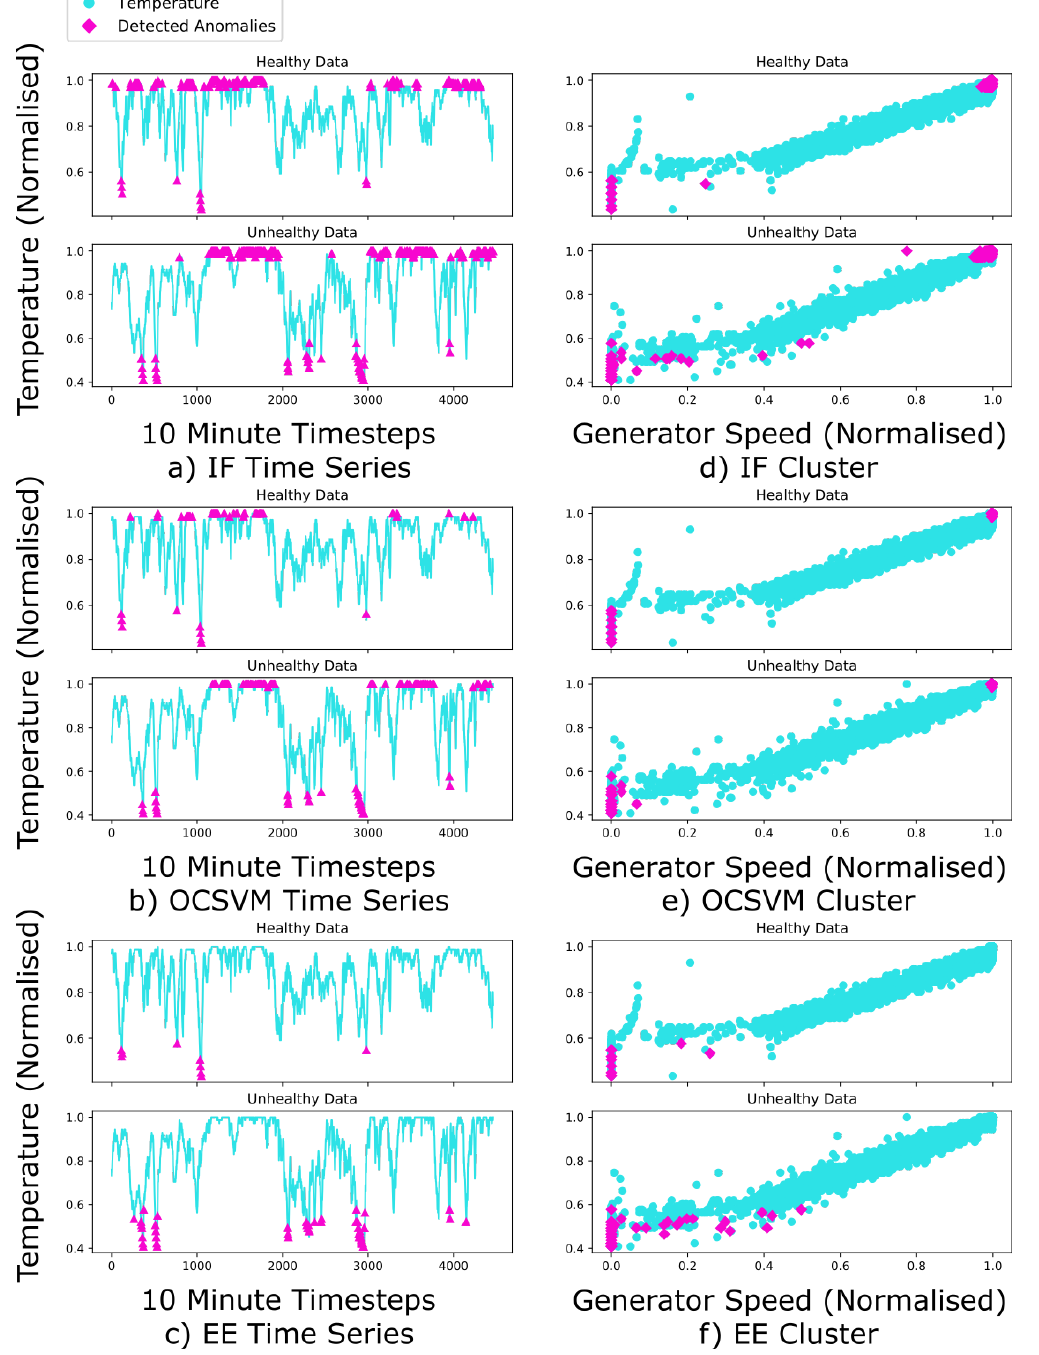
Figure 4. These figures show anomalies for the generic training regime with normalised data from the temperature target with four inputs. ( a – c ) The blue (light) line shows the normalised main bearing temperature data. The pink (dark) triangles show when anomalies were detected during the two months. ( d – f ) The blue (light) circles shows the normalised main bearing temperature data. The pink (dark) diamonds show when anomalies were detected during the two